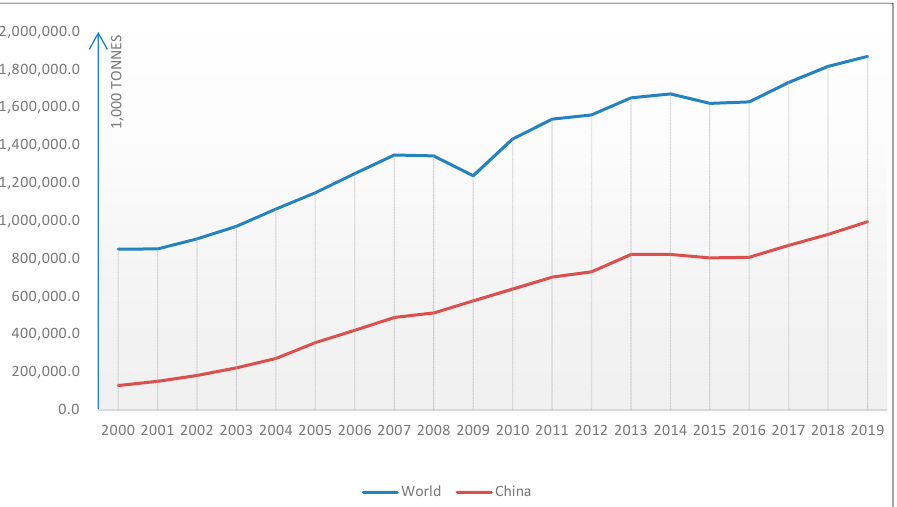
Figure 1. Total production of crude steel in China and the world from 2000 to 2019.